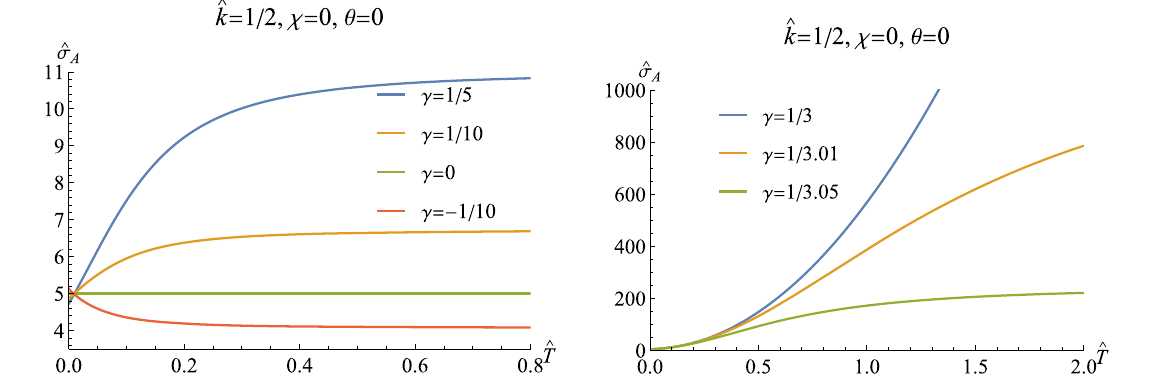
Fig. 1 Electric conductivity ˆ σ A as a function of the temperature ˆ T , with specified ˆ k = 1 / 2 and varying different γ . Here, we’ve set χ = 0 ,θ = 0